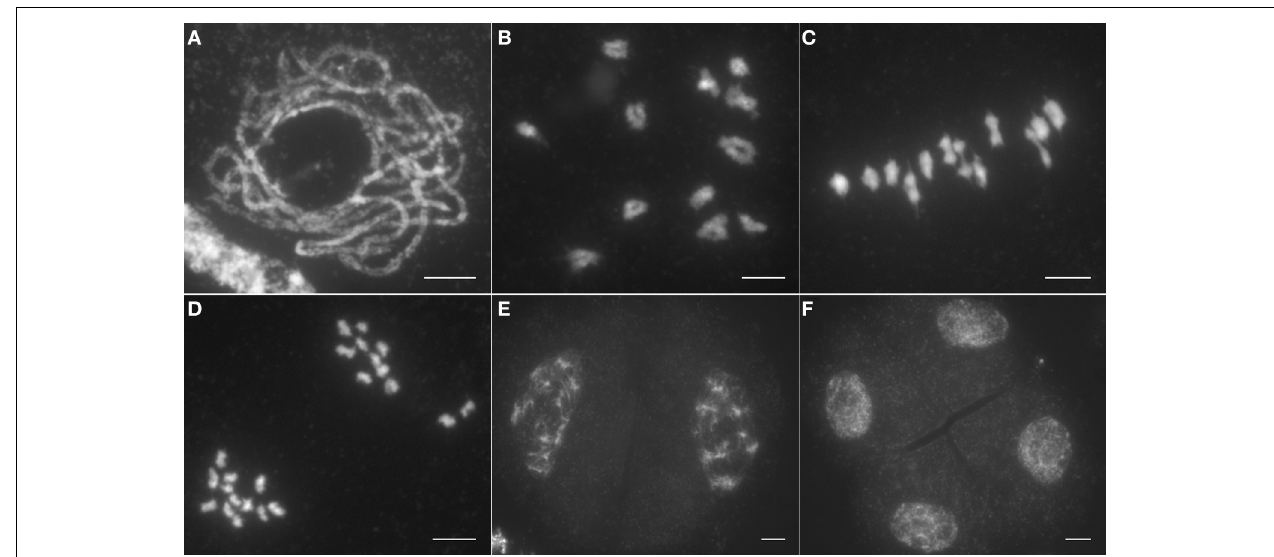
FIGURE 1 | Male meiosis in wild type. (A) Pachytene; (B) Diakinesis; (C) Metaphase I; (D) Anaphase I; (E) Dyad; (F) Tetrad. Bars, 5 μ m.